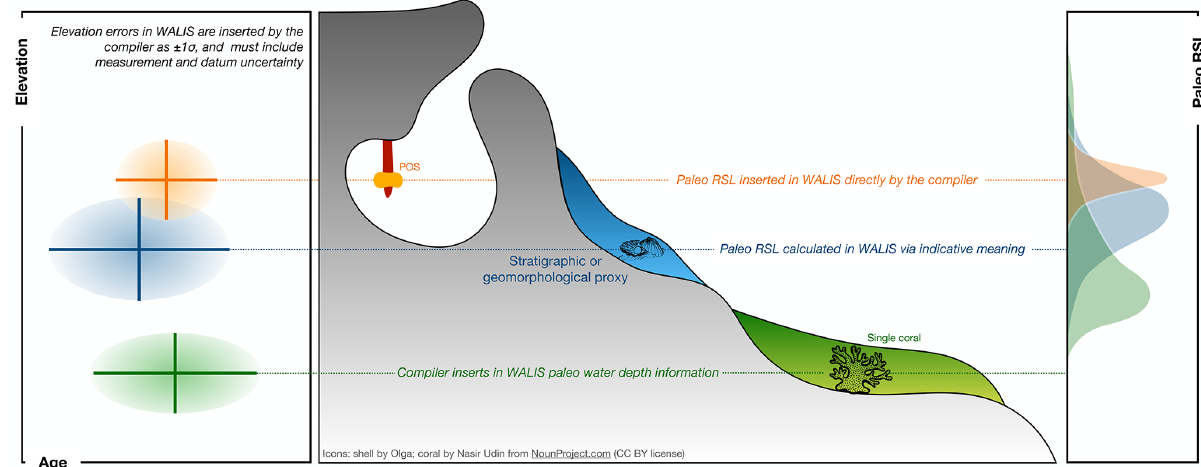
Figure 10. Three types of index points in WALIS 1.0 and associated elevation (left) and paleo RSL information (right). The figure represents the ideal case of three index points formed at the same time (overlapping ages within error bars), surveyed at different elevations but resulting in a coherent paleo RSL history (overlapping paleo RSL) once interpretation of proxies is included. POS is phreatic overgrowth on